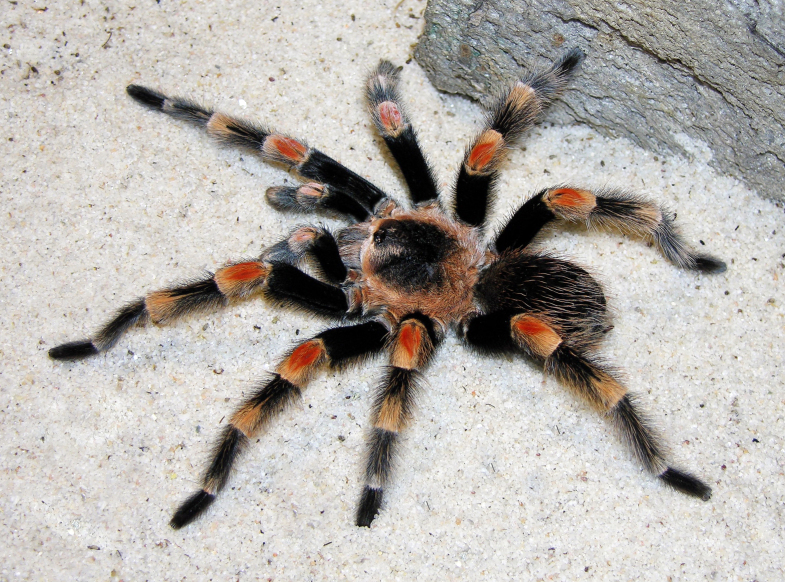
Brachypelma
hamorii Tesmoignt, Cleton & Verdez, 1997 male from Colima state, Mexico. Photo: Rick C. West.